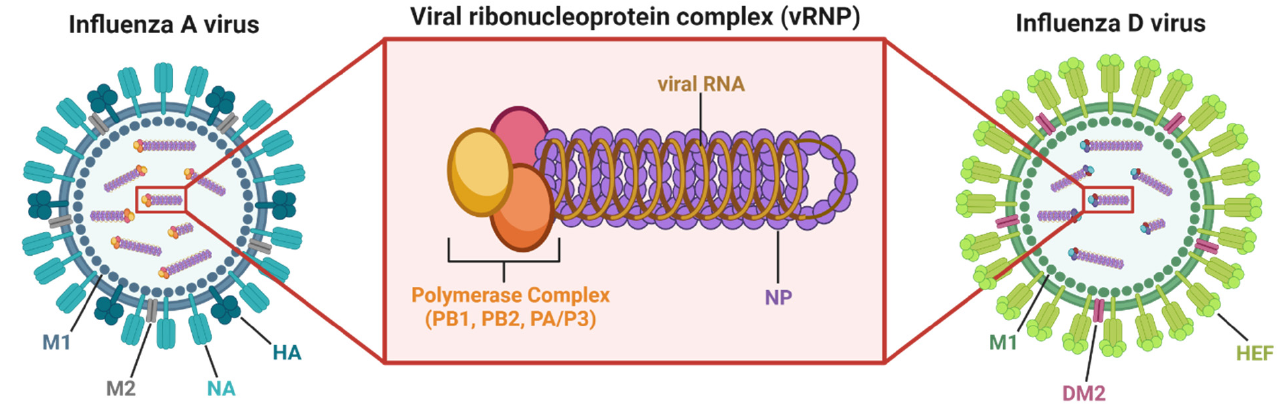
Figure 2. Influenza virus and viral ribonucleoprotein (vRNP) structure. Examples of IAV and IDV are shown, with vRNP structure for IAV magnified. IAVs are studded with the cell surface proteins hemagglutinin (HA) and neuraminidase (NA), while IDVs are studded with the cell surface protein hemagglutinin esterase fusion (HEF). Influenza viruses also have ion channels (M2 for IAV, DM2 for IDV) along their surface and contain an inner matrix of envelope support proteins (M1 for IAV and IDV). As shown for IAV, each of the RNA gene segments are individually wrapped into vRNP complexes which consist of the viral polymerase complex (for IAV, proteins PB1, PB2, and PA) bound to a viral RNA (vRNA) segment neatly surrounded by several copies of viral nucleoprotein (NP). This structure helps initiate transcription and replication of the viral RNA genome within the nucleus of an infected host cell [30]. Figure created with BioRender.com was generated with assistance from ref. [30]: Dou et al., 2018.